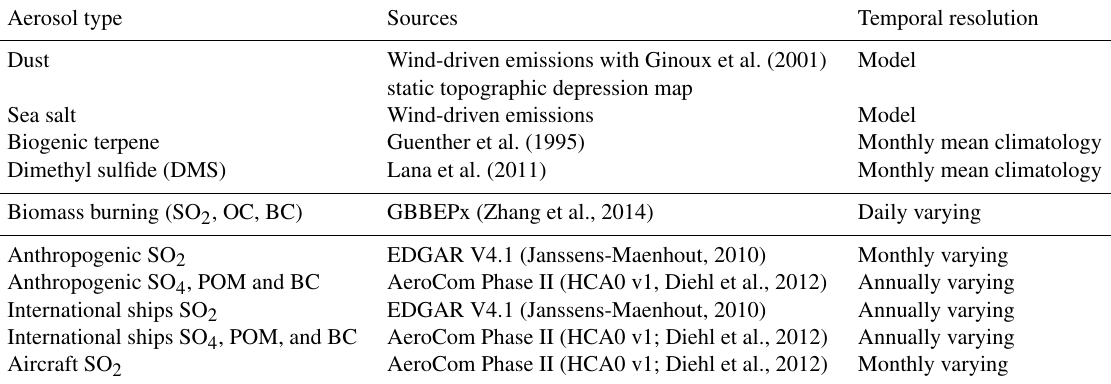
Table 1. Aerosol and precursor emissions in